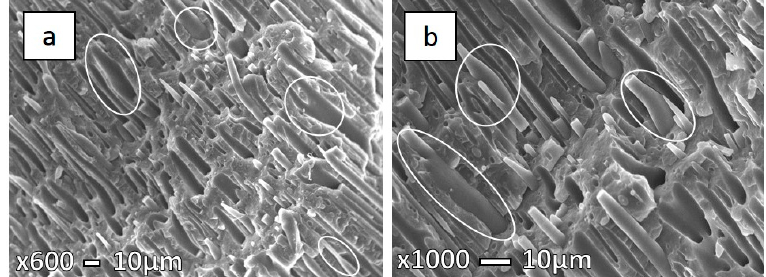
Figure 8. SEM micrographs of freeze-fracture surfaces in the parallel direction under liquid nitrogen